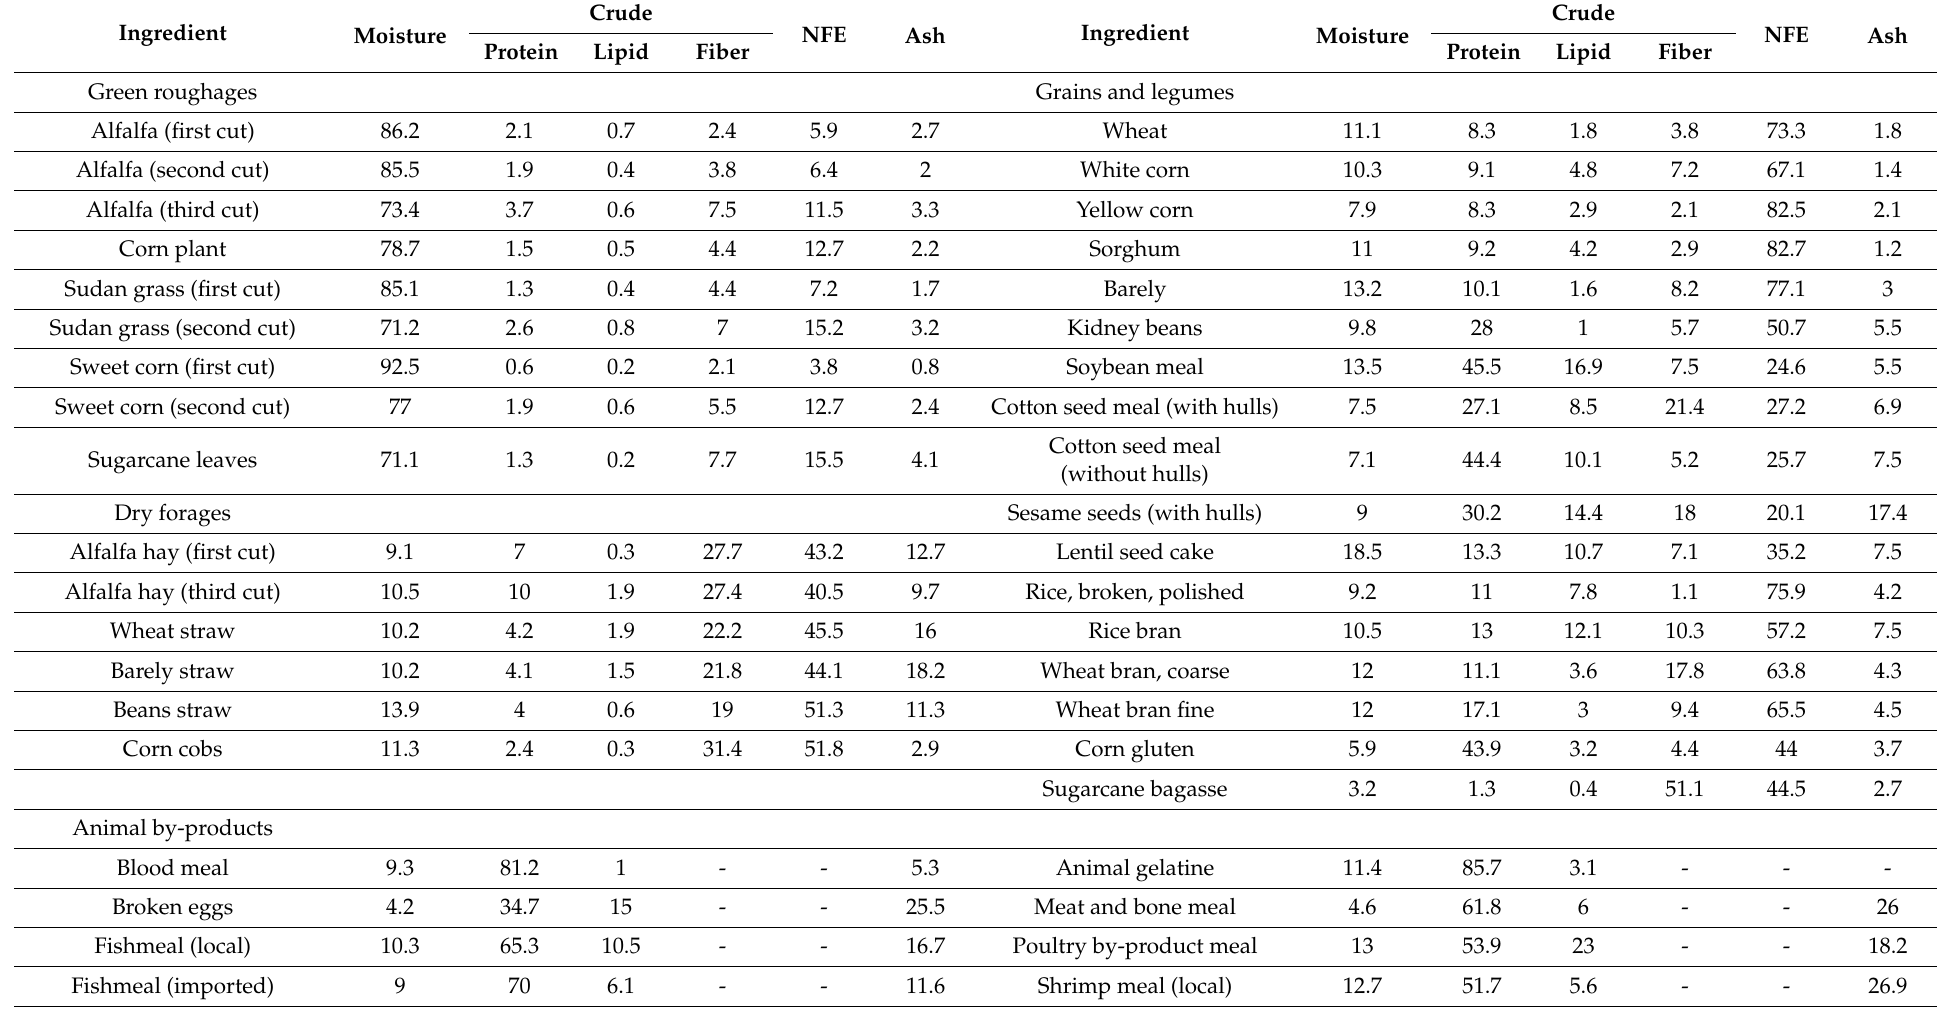
Table 6. Nutritional value of some feed ingredients utilized in aquafeed